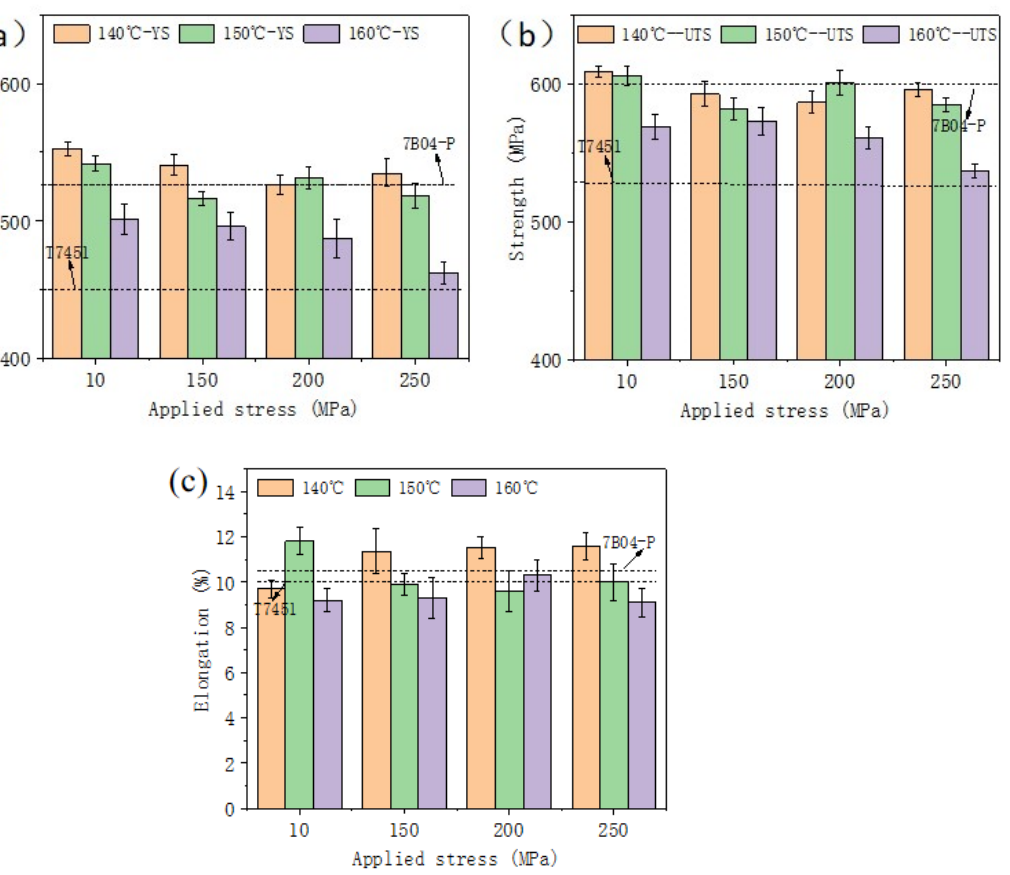
Figure 6. Mechanical properties of 7B04-P al alloy samples after creep aging under different applied stress: ( a ) yield stress; ( b ) unlimited tensile stress; ( c ) elongation.